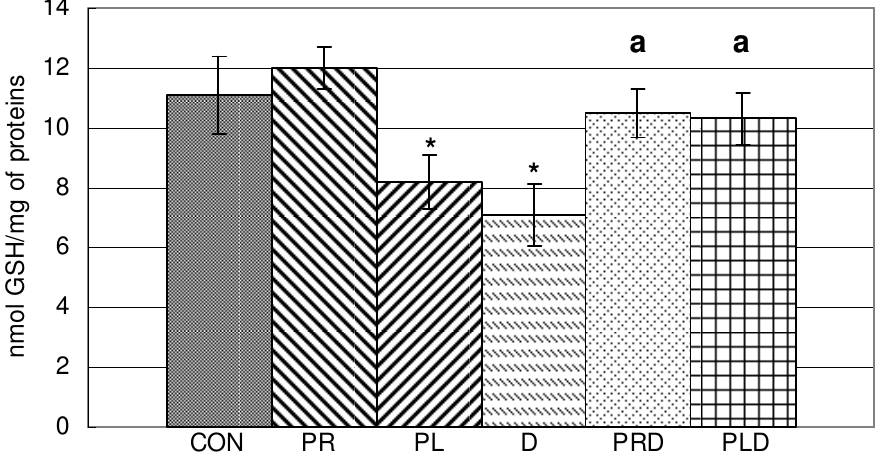
Figure 1. Content of reduced glutathione in liver homogenate of animals treated with doxorubicin, parsley leaves and roots juices and their combination. t-test, n =  6; compared to CON group: * p < 0.05, compared to D group: a p <